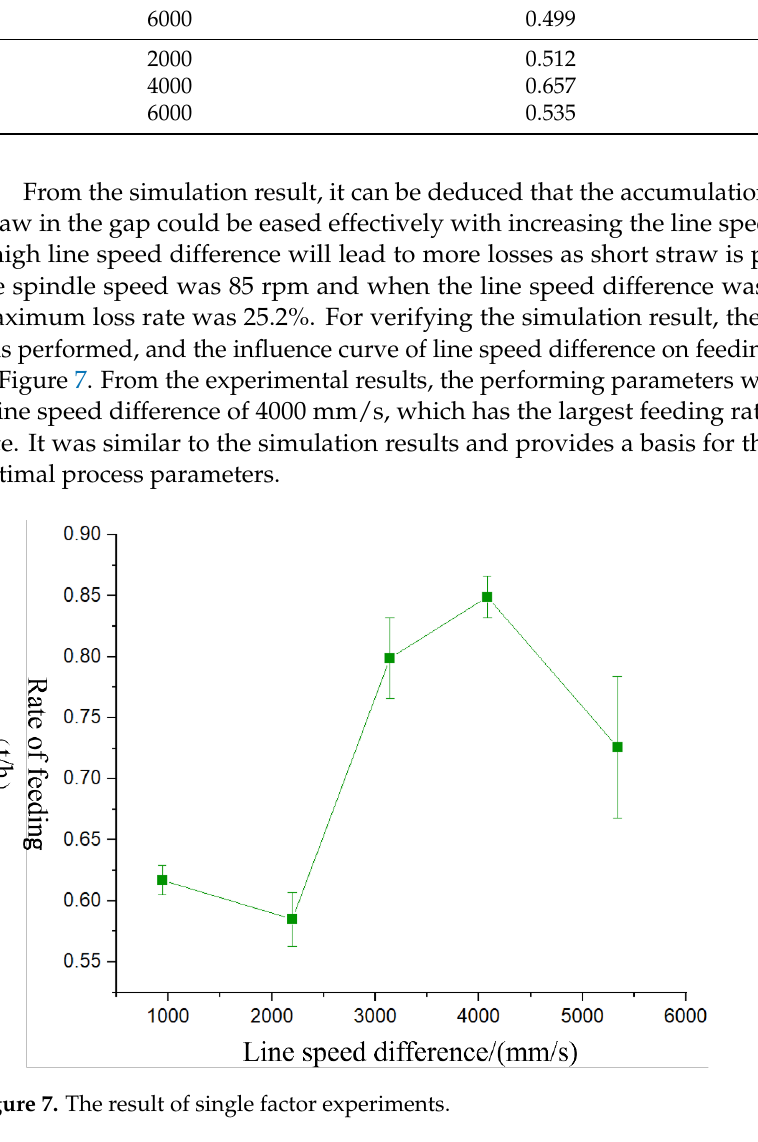
Figure 8. D200 straw fiber making machine. 2.7. Experimental Materials and Equipment In this study, rice straw from Suixian No.9, Suilan County, Suihua City, was selected as the test material. Before the test, rice straw was soaked in normal temperature water for 8 h to reach saturated moisture content.